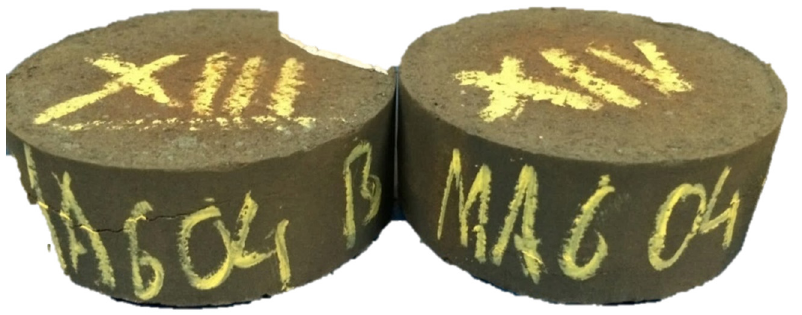
Figure 15. Exemplary MA604B agglomerates manufactured with a 10 N / mm 2 manufacturing pressure (MP).